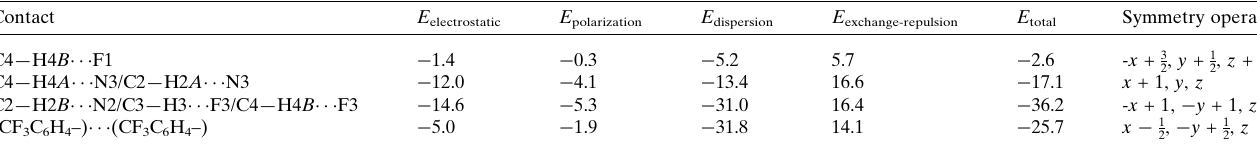
Table 2 Interaction energies (kJ mol (cid:5) 1 ) for selected close contacts in the crystal of (I). Contact E electrostatic E polarization E dispersion E exchange-repulsion E total Symmetry operation